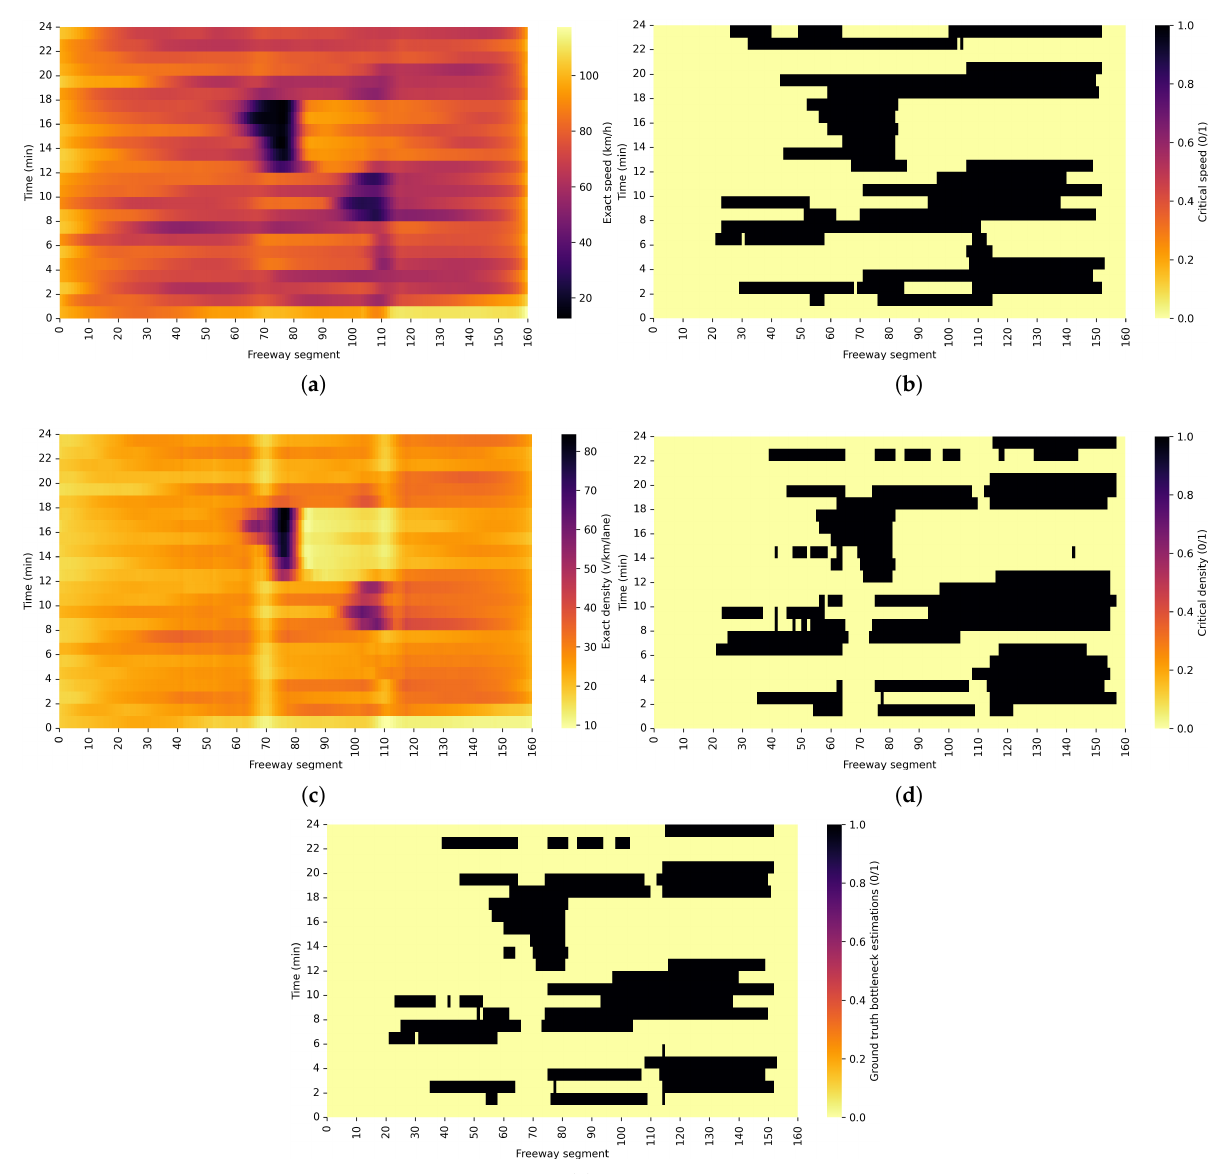
Figure 8. Ground truth data creation process for validation of the proposed method. ( a ) Exact values of the speed measurement; ( b ) Binary image where 1 represents critical speed; ( c ) Exact values of the density measurement; ( d ) Binary image where 1 represents critical density; ( e ) Intersection of critical speed and density